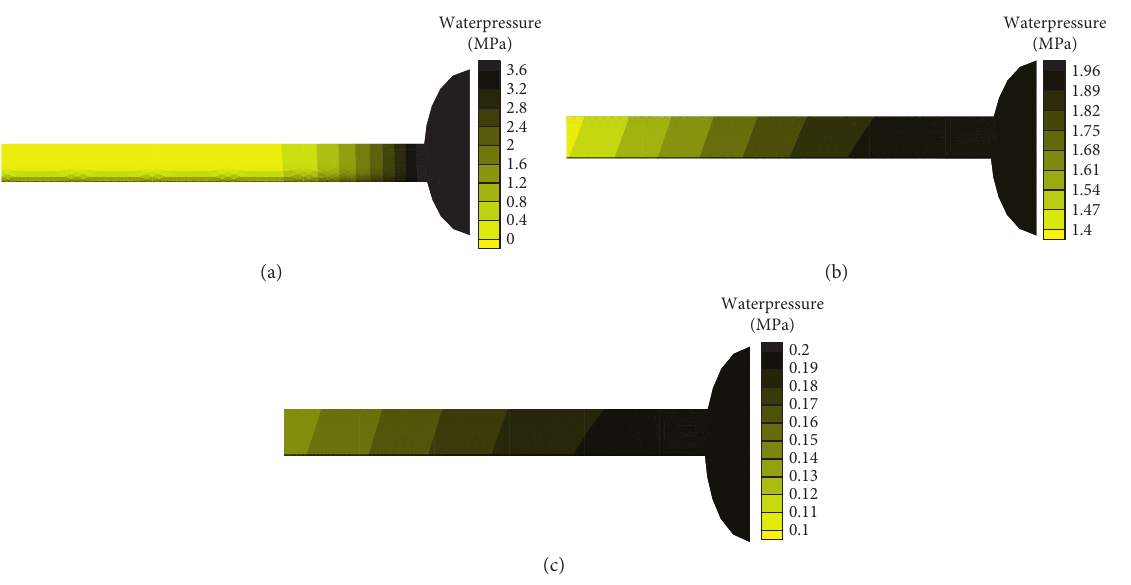
Figure 17: The water pressure distributions in the roadway by pipe analysis analysis in different times. (a) t � 0.14h. (b) t � 3.53h. (c) t � 9.44 h.